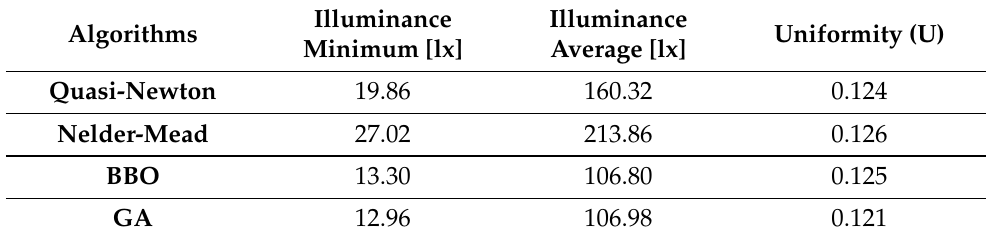
Table 5. Illuminance and uniformity ratio for the different optimization